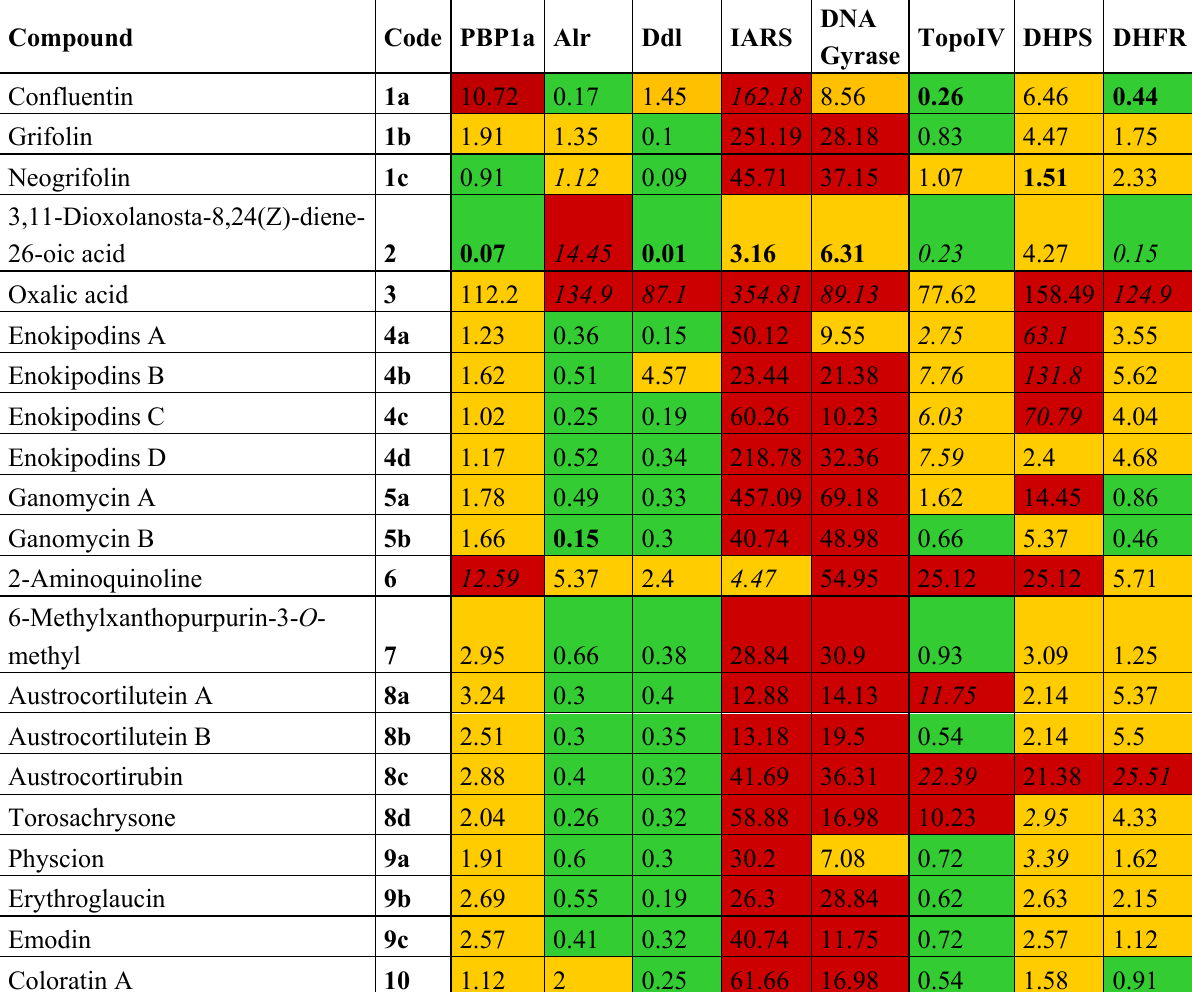
Table 2. Predicted Xscore Ki (µM) of mushroom compounds with antimicrobial activity against proteins involved in antimicrobial mechanisms of